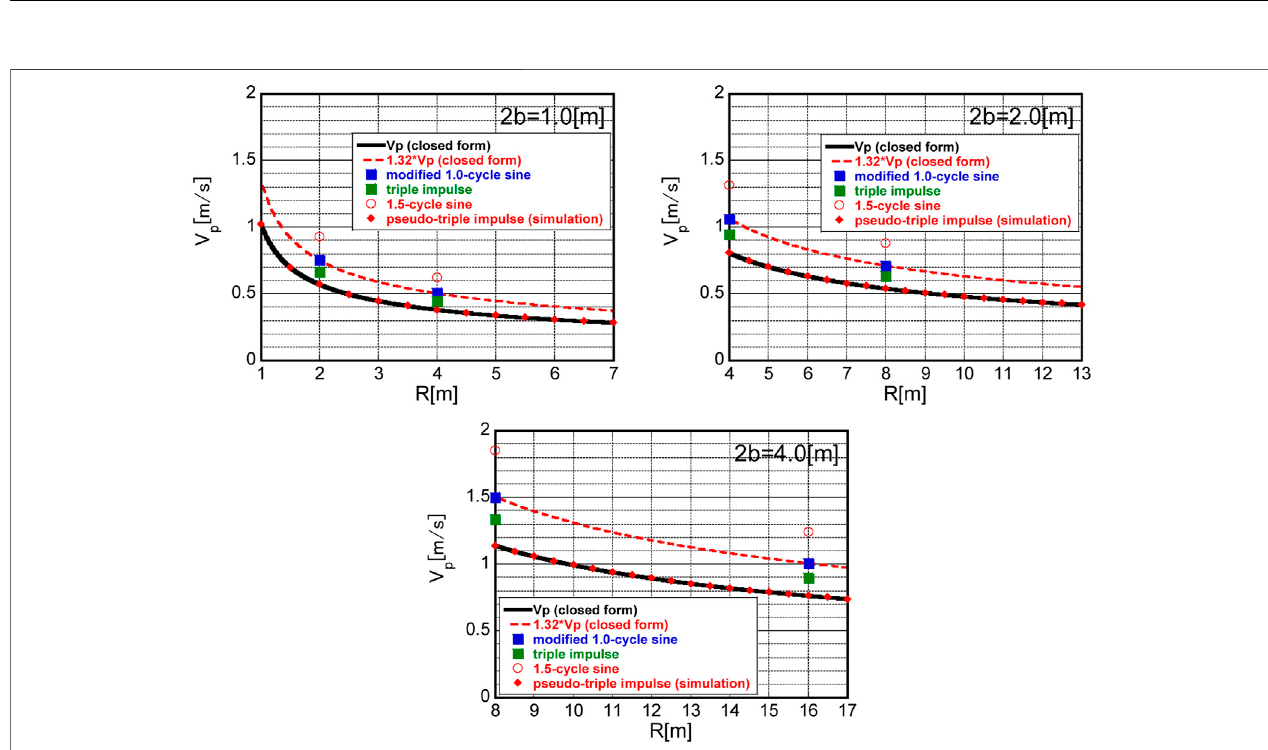
FIGURE12| Comparisonofoverturninglimitvelocityamplitude V P amongclosed-formlimitusingpseudo-tripleimpulse(consistingofthe fi rsttwoimpulsesintriple impulse), triple impulse limit, equivalent modi fi ed 1.0-cycle sinusoidal wave limit and 1.5-cycle sinusoidal wave limit.